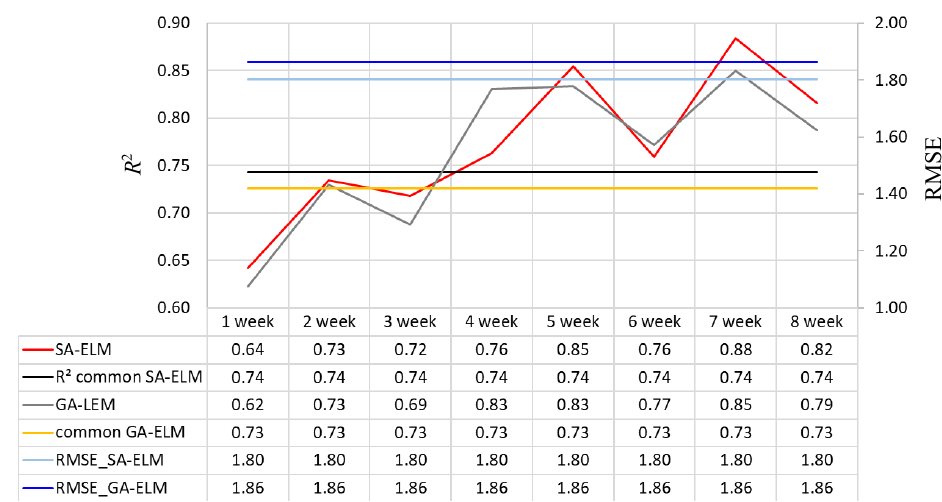
Fig. 8. Simulation results dependency on the measurement period .